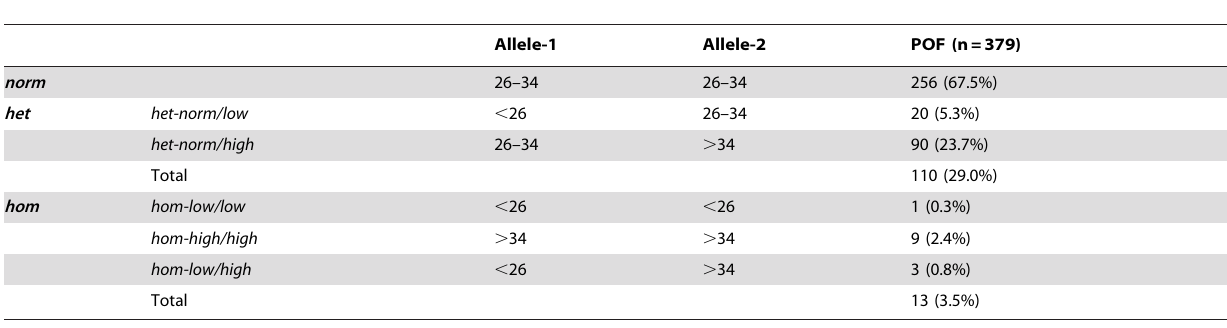
Table 2. Distribution of FMR1 genotype and sub-genotype in sporadic POF patients.